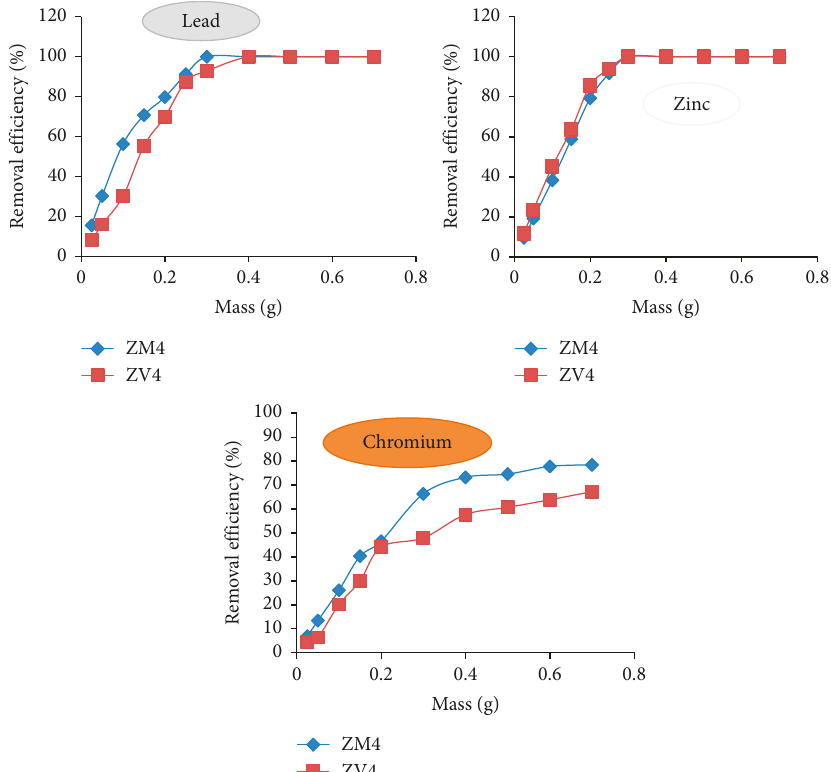
Figure 9: Effect of mass adsorbent on the removal of heavy metals by ZV4 and ZM4.